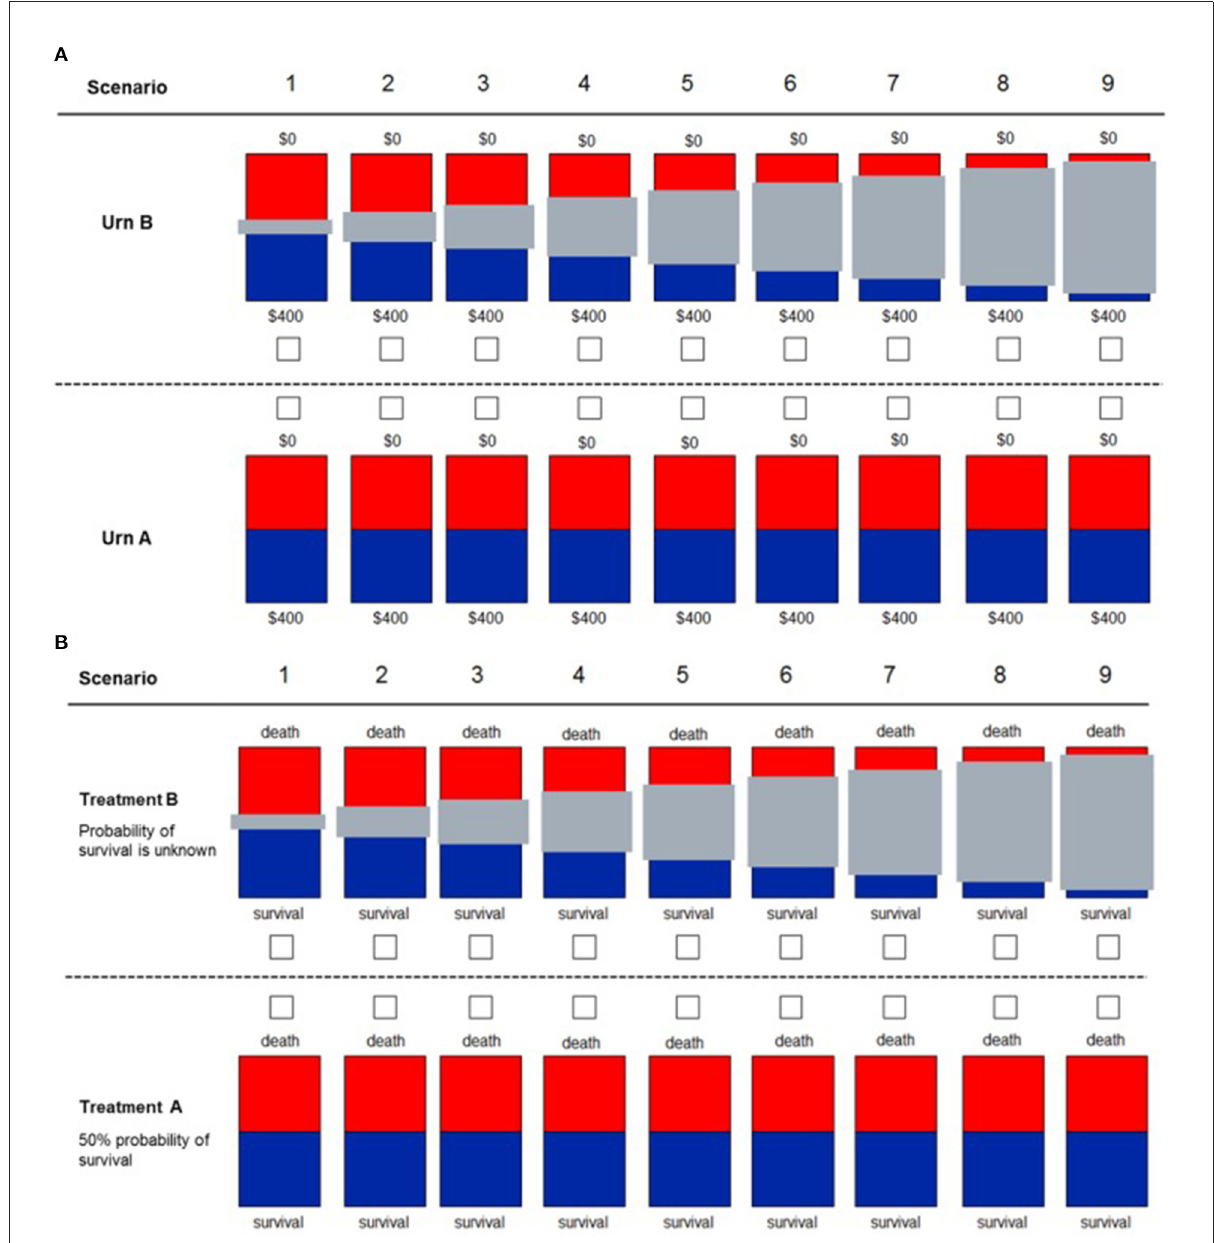
FIGURE3 Decision scenarios used to measure ambiguity in financial (A) and health (B) domains. Participants are presented with two different urns. For urn type A, they knew that 50% of the balls were red and the other 50% were blue. For urn type B, they do not know the exact proportion of blue to red balls, with the gray bar representing the unknown proportion of balls (degree of uncertainty). For the financial domain, participants know that if they drew a blue ball, they would win the full amount of $400. If they drew a red ball, they would win $0. For the health domain, participants have to decide between two treatments for a patient. With “Treatment A,” the patient had a 50% probability of survival. With “Treatment B,” the exact probability of survival was unknown, with the gray bar representing the unknown probability (uncertainty). This figure was reproduced from Saposnik et al.